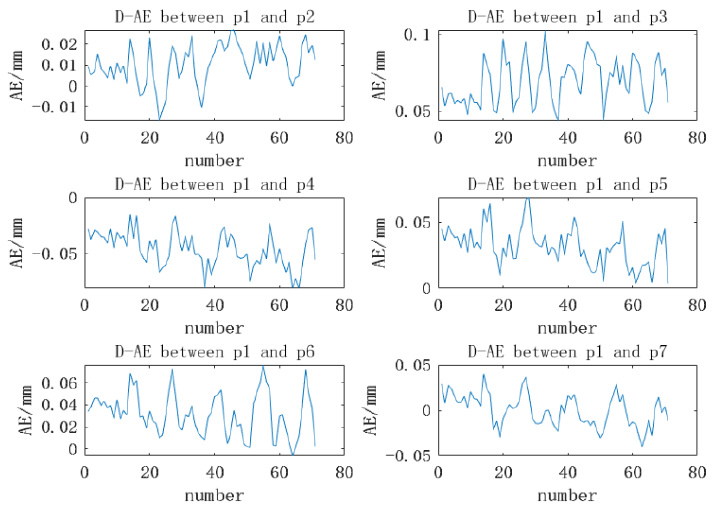
Figure 10. Comparison of the reconstruction distance and the actual distance.